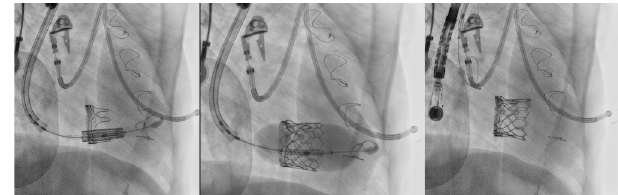
Fig. 2 - Valve implantation exposed in a